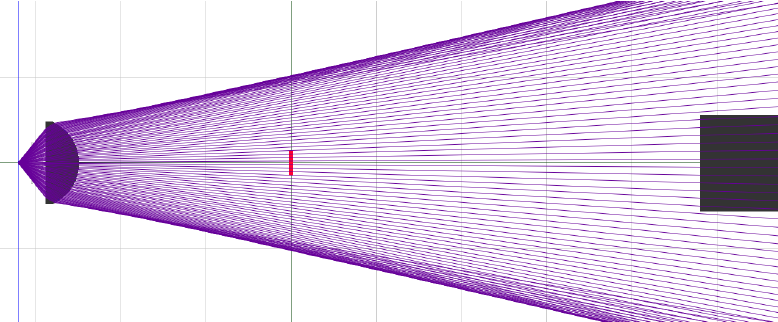
Figure 2. Ray tracing simulation showing the output radiation of the light-emitting diode (LED) emitter on the left. The LED output is collected and transmitted by a 16 mm focal length condenser lens. The probe volume is shown in red and the microscope objective’s effective collection is represented by a dark gray